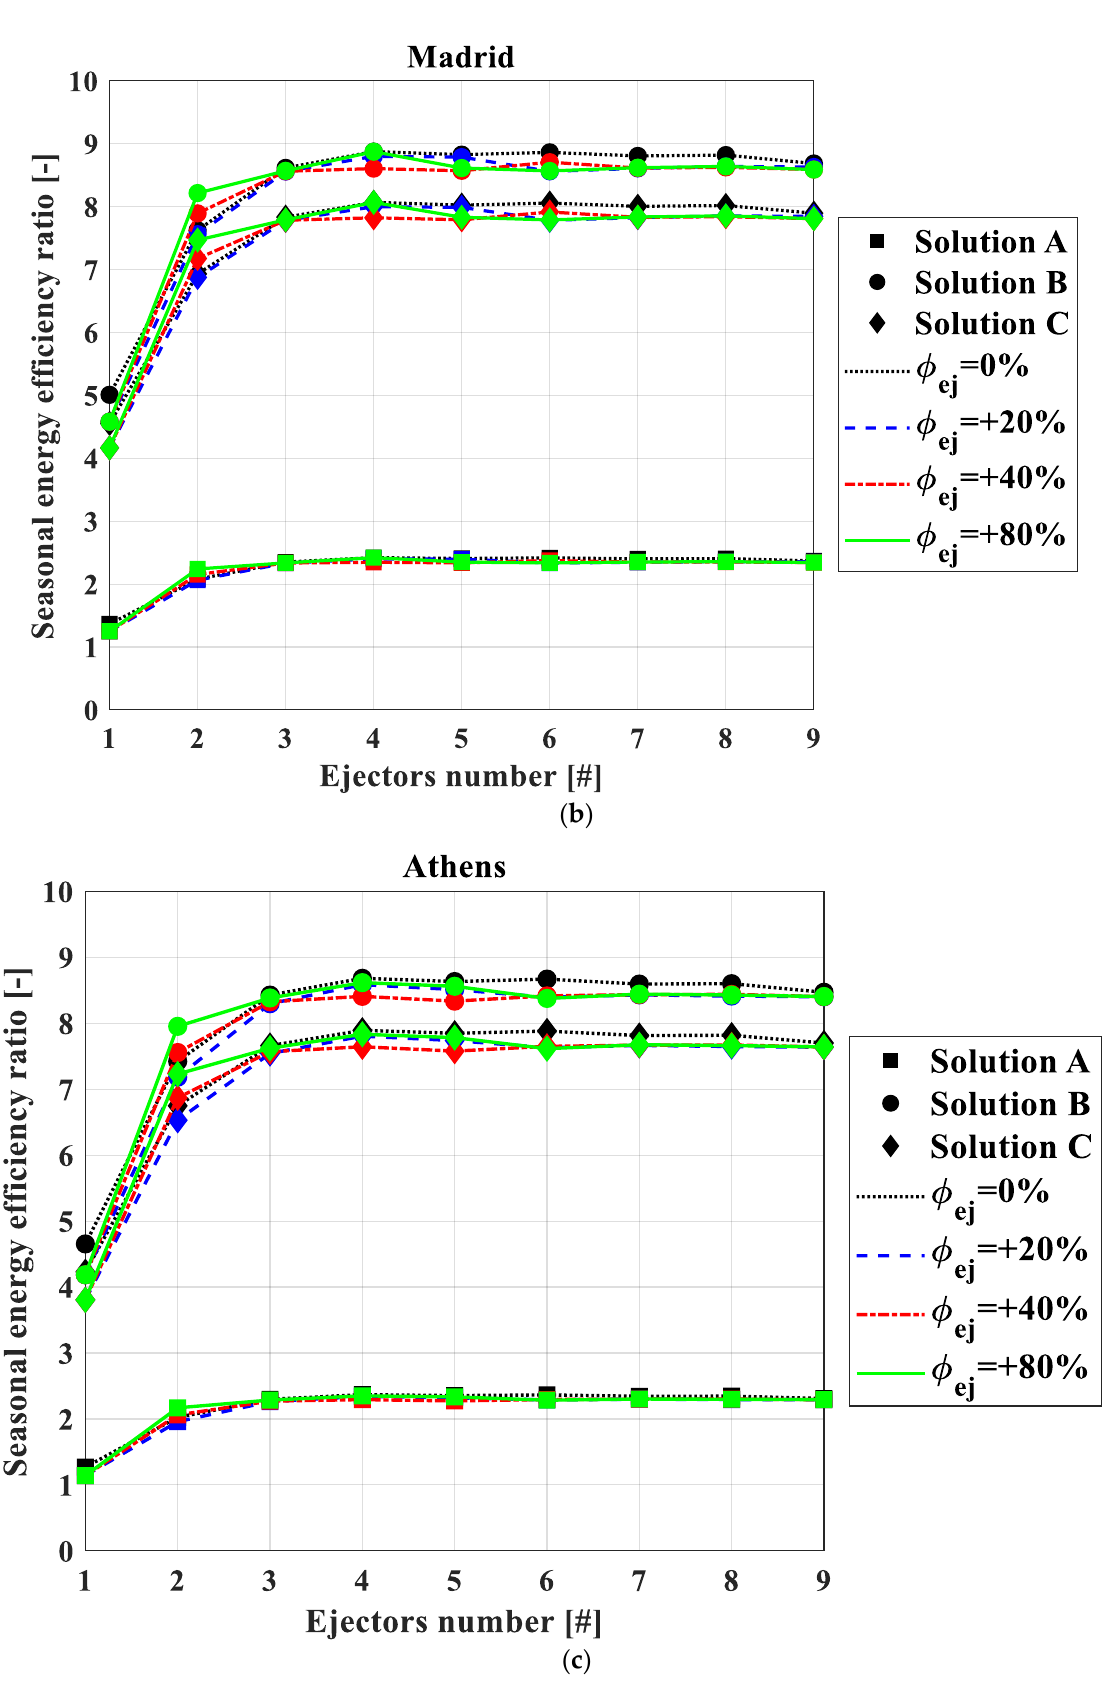
Figure 7. Seasonal performance as function of number of ejectors for ( a ) Milan, ( b ) Madrid, ( c ) Athens and multi-ejector configuration.